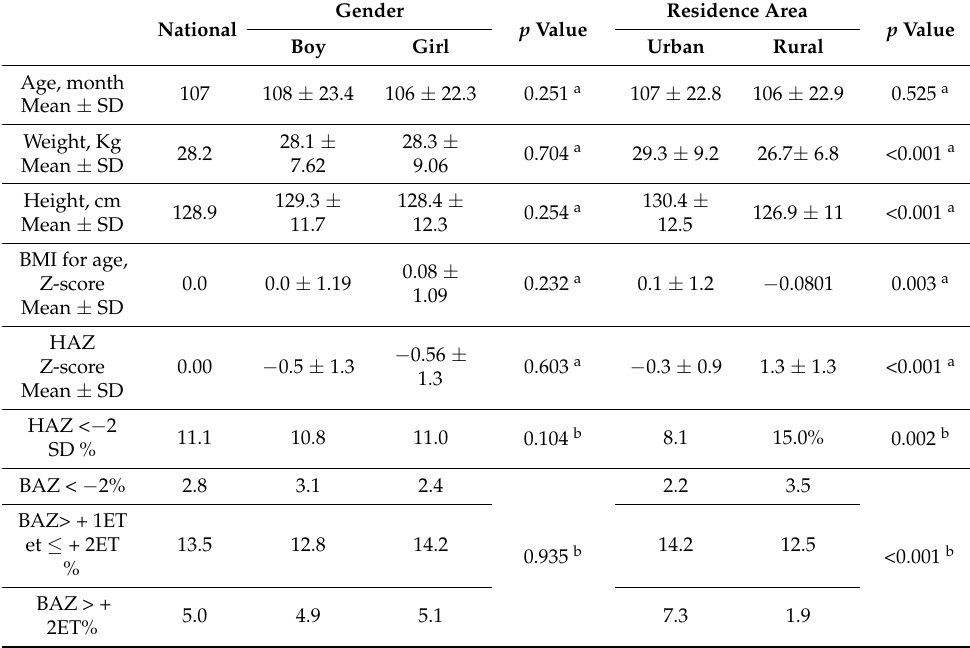
Table 2. Age and anthropometric characteristics of the studied